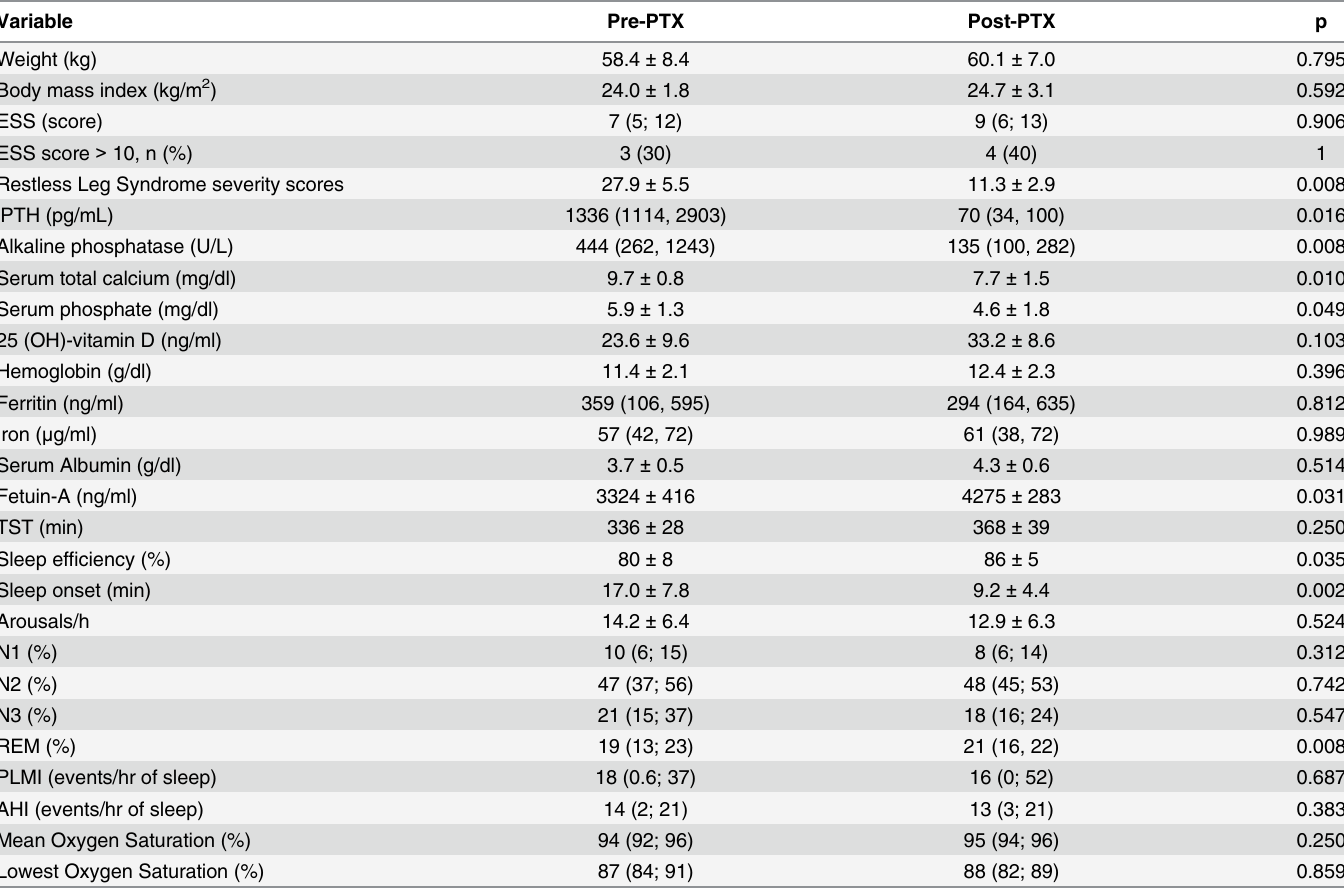
Table 3. Clinical, biochemical and polysomnographic findings pre- and post-parathyroidectomy (PTX) of patients with Restless Legs Syndrome